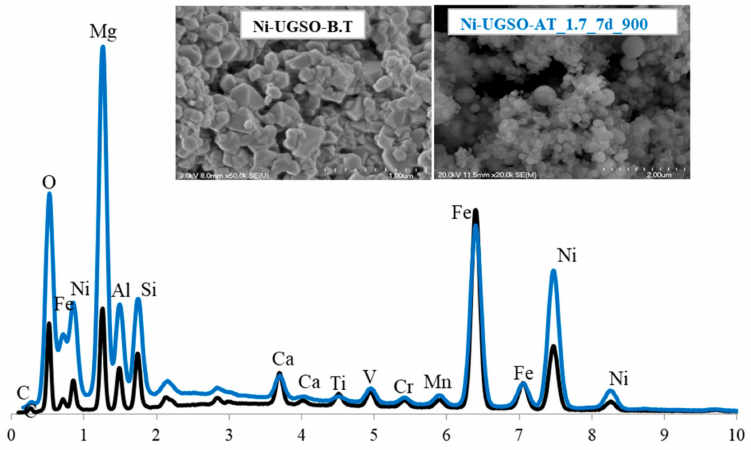
Figure 8. SEM and EDX of Ni-UGSO BT and Ni-UGSO AT (7 days, H 2 O/CH 4 = 1.7, 900 ◦ C).